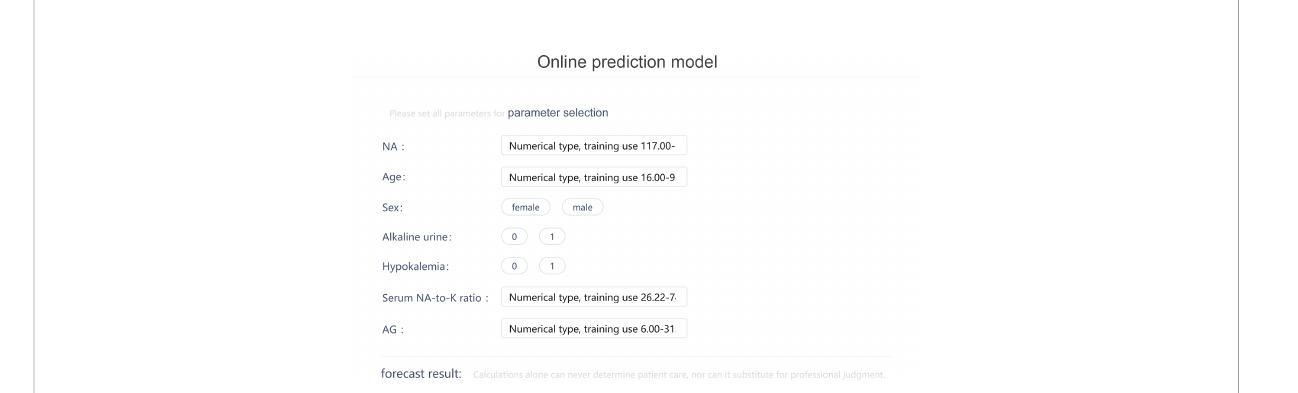
FIGURE 4 The visualization of the prediction model through Deepwise and Beckman Coulter DxAI